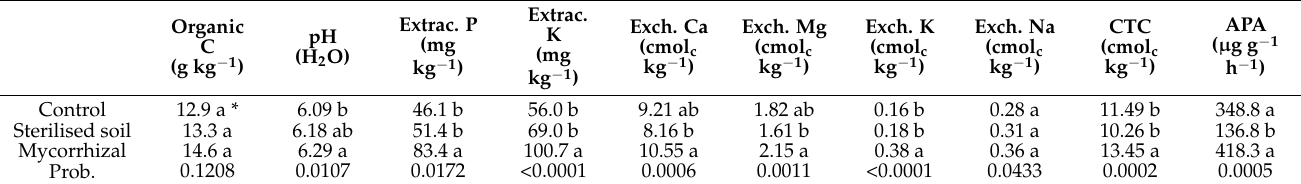
Table 6. Organic carbon (C), pH (H , extractable phosphorus (P) and potassium (K), exchangeable calcium (Ca), magnesium 2 O) (Mg), K and sodium (Na), cation exchange capacity (CEC), and acid phosphatase activity (APA) in the growing medium at the end of the